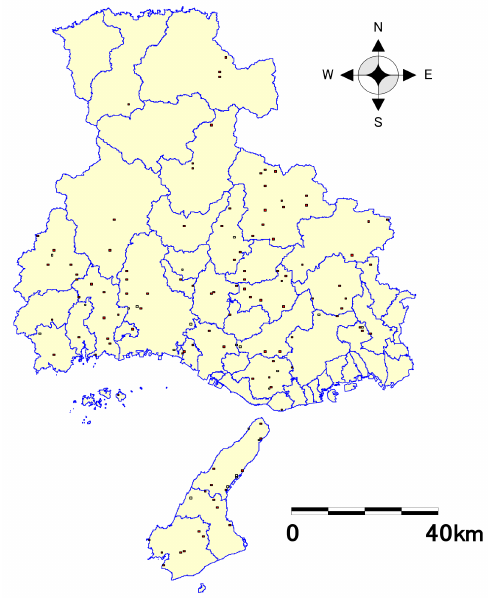
Figure 10. Mega PV solar plants installed in high landslide risk